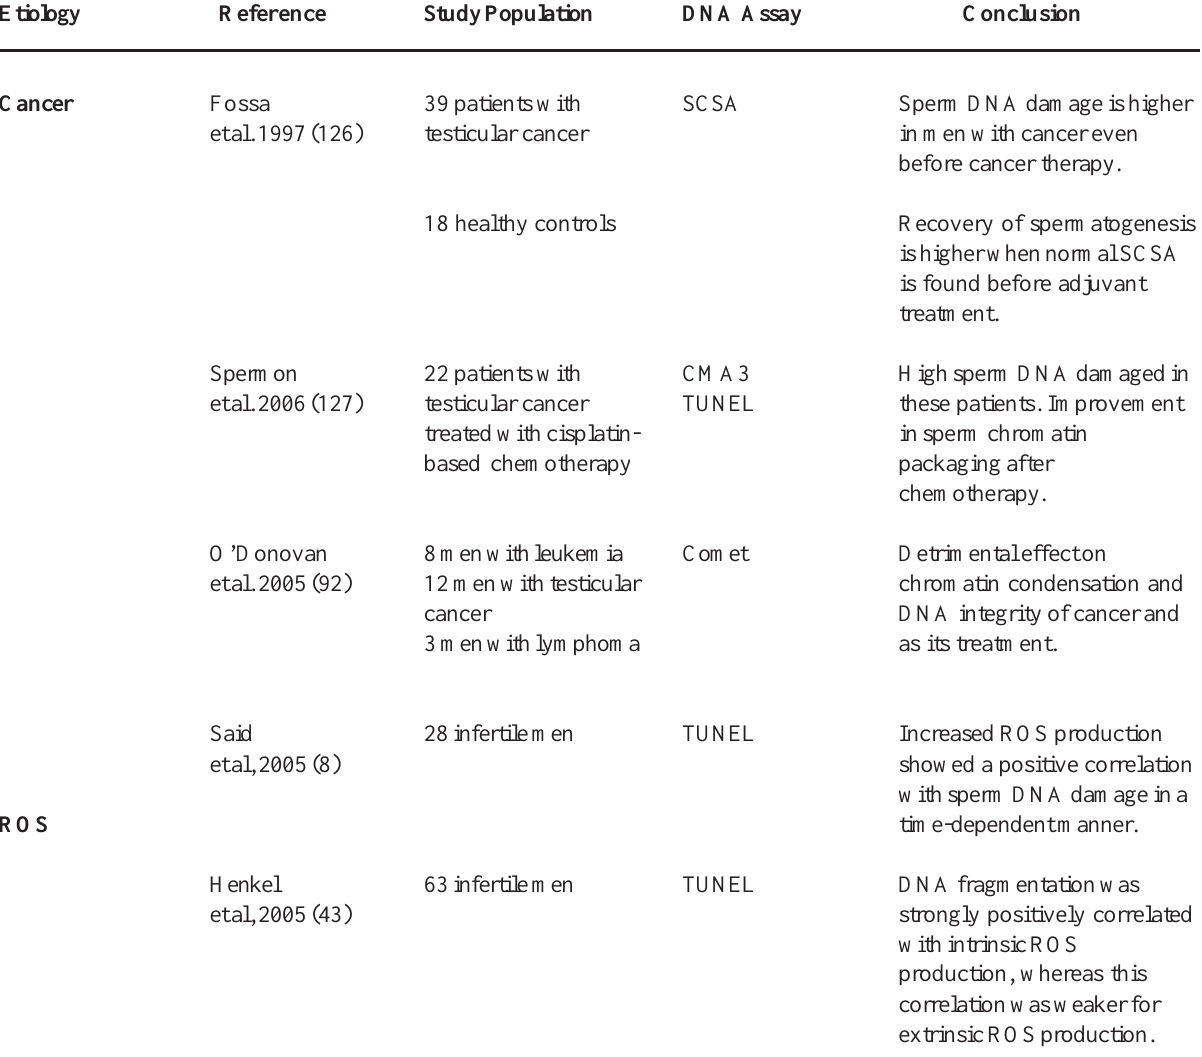
Table 1 – Etiological factors associated with increased human sperm DNA damage. (continued